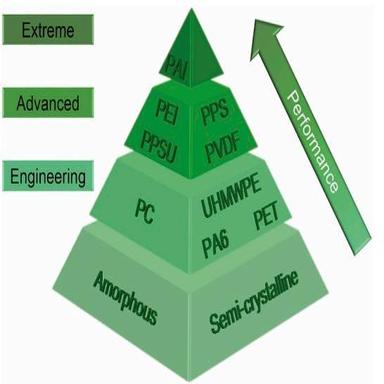
Thermoplastics provided by Quadrant EPP Belgium.